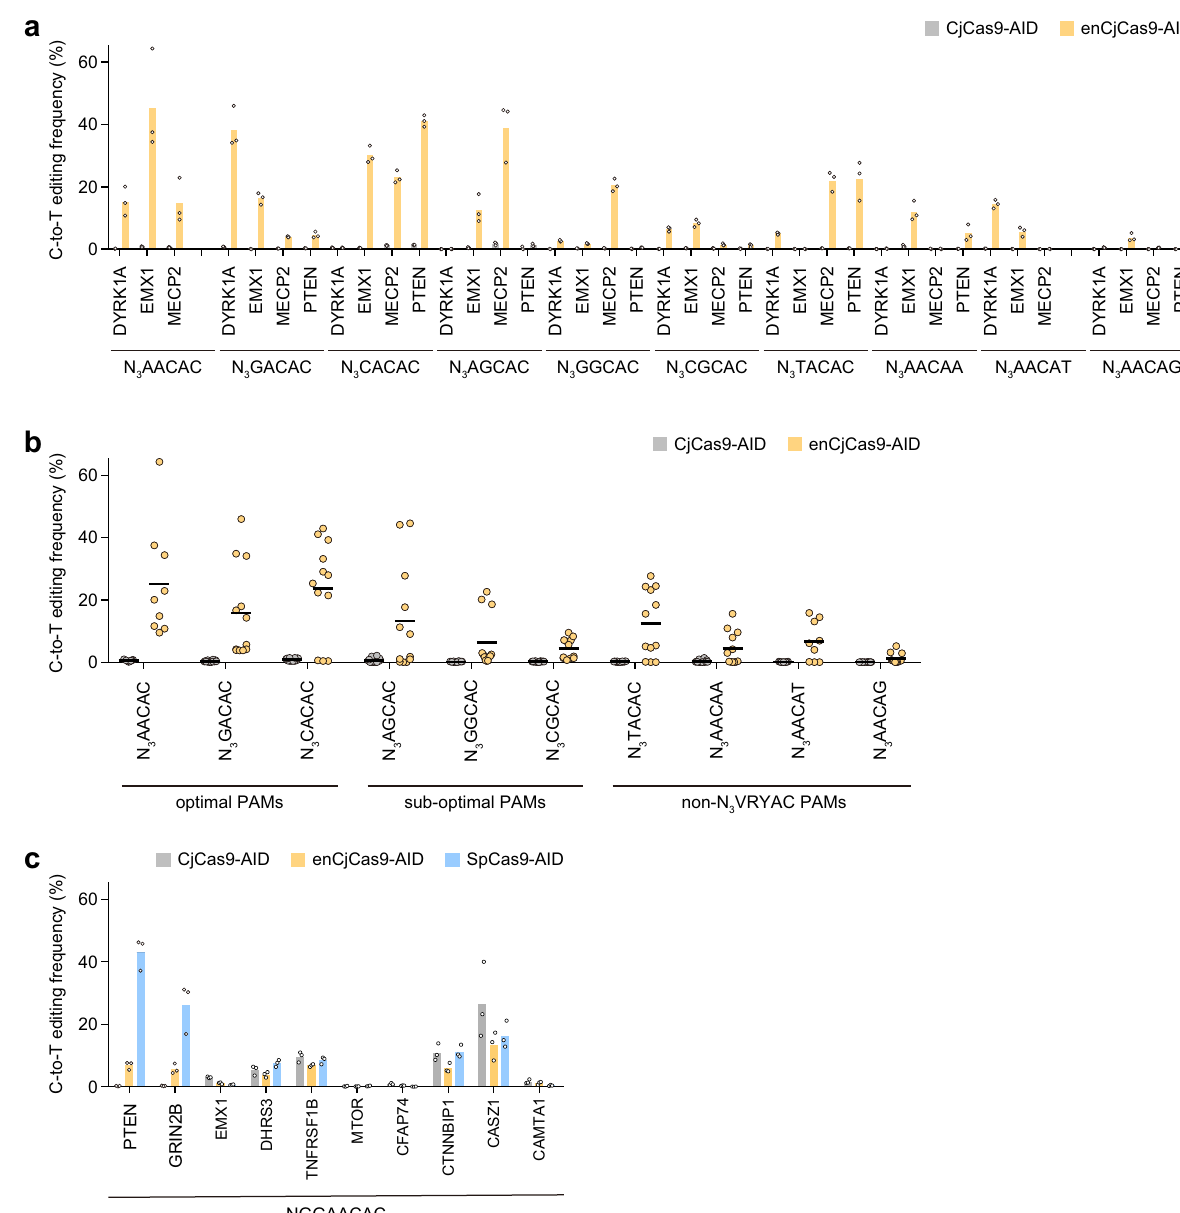
Table 1). Next, the cleavage activities CjCas9 were measured, using the optimal 22- nt guide sgRNA and linearized pUC plasmids with 16 different PAMs. The line- arized plasmid DNA (100ng, 4.7nM) was incubated at 37 °C for 0.5 – 5 min with the CjCas9 – sgRNA complex (50 nM) in 10 μ L of reaction buffer, containing